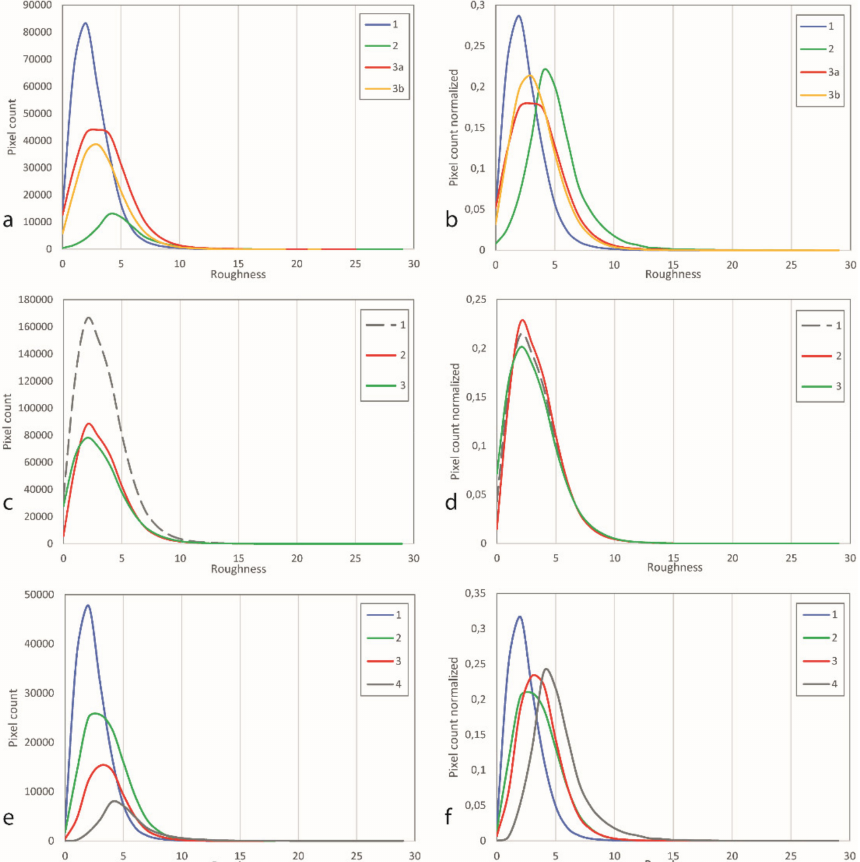
Figure 8. Trends of the R variable: ( a ) in the sectors subdividing the study area: Pesaro–Punta degli Schiavi (1), Punta degli Schiavi–Mt. Brisighella (2), Mt. Brisighella–Castel di Mezzo (3a), and Castel di Mezzo–Vallugola (3b); ( b ) in the sectors subdividing the study area considering normalized values: Pesaro–Punta degli Schiavi (1), Punta degli Schiavi–Mt. Brisighella (2), Mt. Brisighella–Castel di Mezzo (3a), and Castel di Mezzo–Vallugola (3b); ( c ) in the total study area (1) in comparison with areas affected (2) or not affected (3) by landslides; ( d ) in the total study area (1) in comparison with areas affected (2) or not affected (3) by landslides considering normalized values; ( e ) for each landslide typology occurring in the study area: slides (1), slumps (2), flows (3), and diffuse instability (4); ( f ) for each landslide typology occurring in the study area considering normalized values: slides (1), slumps (2), flows (3), and diffuse instability